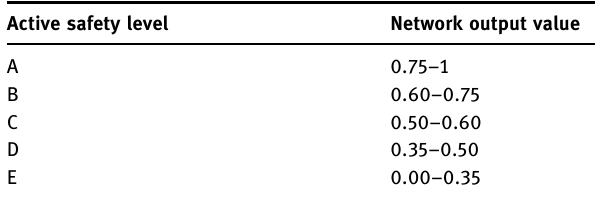
Table 1: Classi fi cation of security and classi fi ed information security levels Active safety